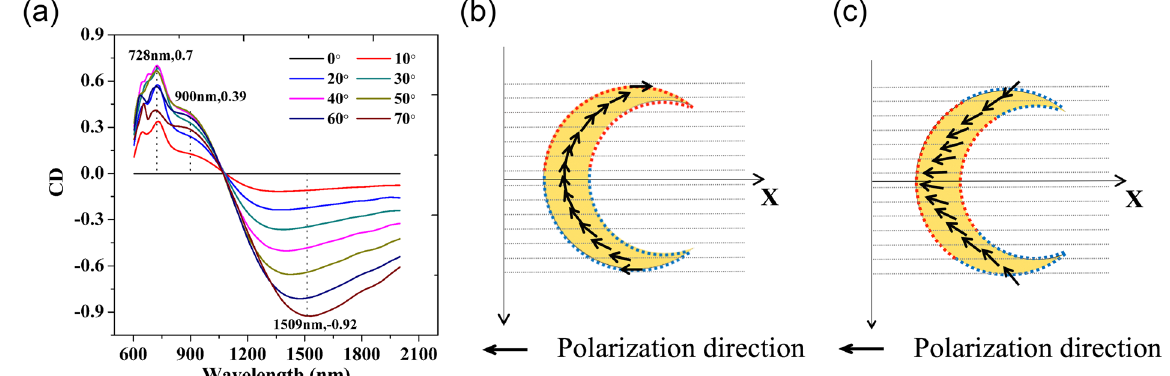
Figure 3. ( a ) The calculated CD spectra of the metal nanocrescent with the increase of θ . ( b,c ) Sketch of the optimum electric field distribution on the surface of the nanocrescent of circularly polarized light to excite dipole and tripolar modes, respectively. The black arrows show the polarization direction of pump light. The red dashed lines stand for positive charges and blue dashed lines stand for negative